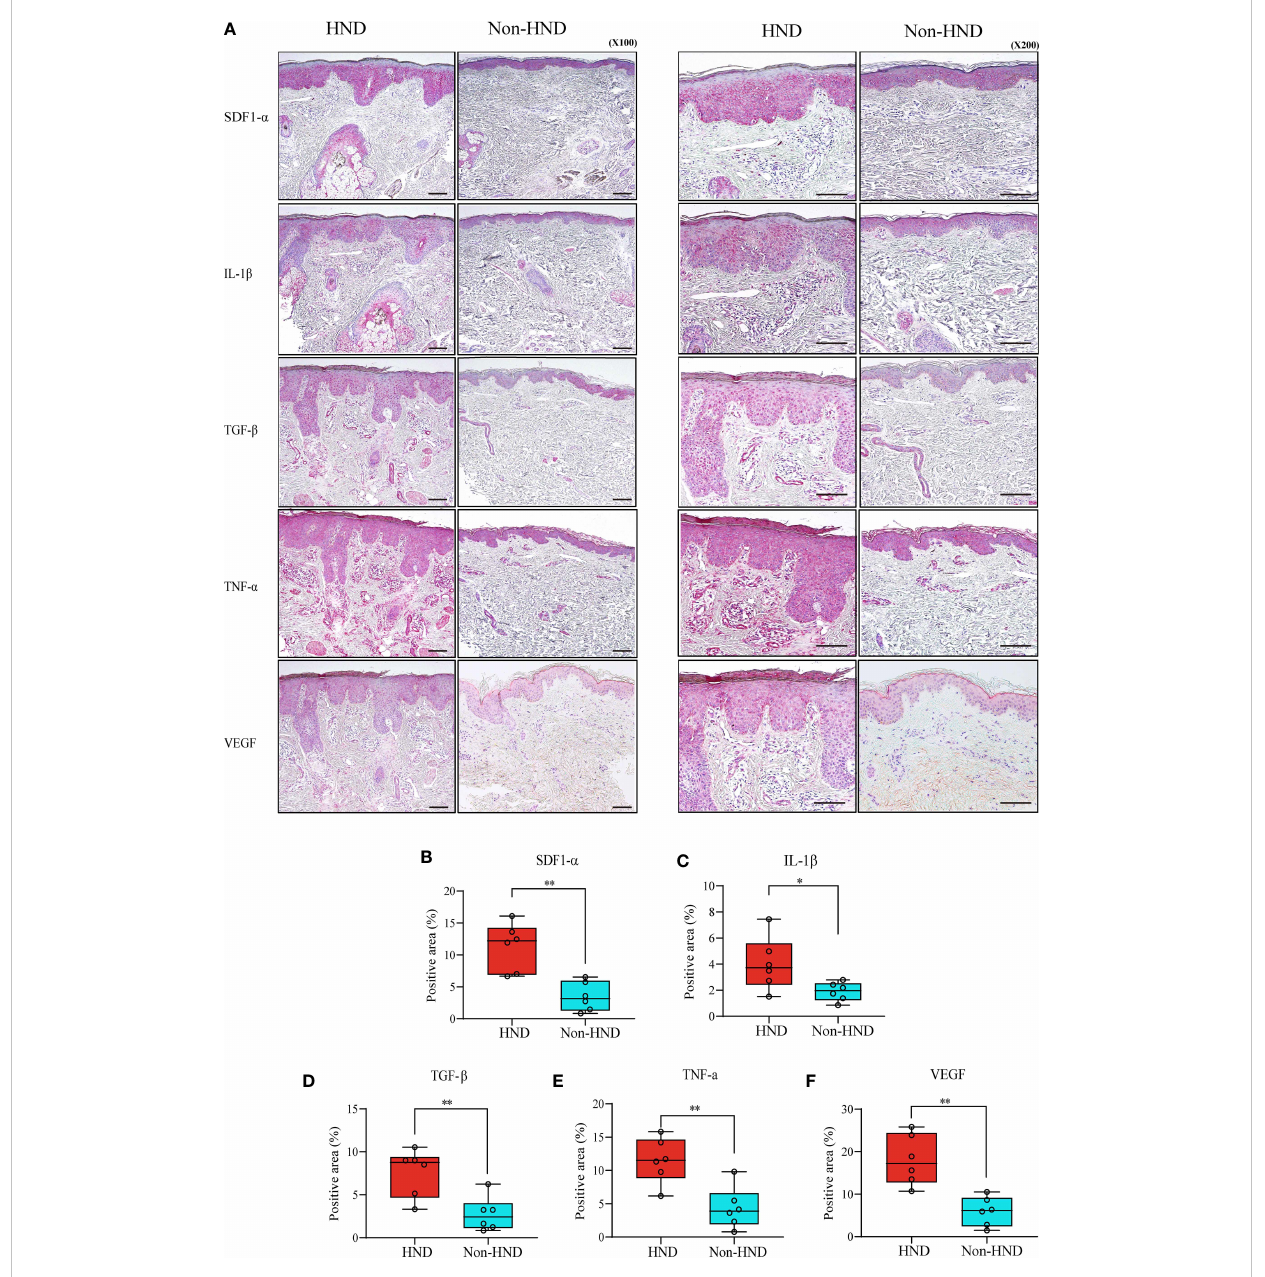
FIGURE 3 Immunohistochemistry of HND and non-HND facial skin specimens. (A) Representative histological image at 100x magni fi cation (left) and 200x magni fi cation (right). Quanti fi ed staining intensity of (B) SDF-1 a , (C) IL-1 b , (D) TGF- b , (E) TNF- a , and (F) VEGF. (Unpaired two-tailed t-test, SDF-1 a ; p = 0.0014, IL-1 b ; p = 0.0374, TGF- b ; p = 0.0058, TNF- a ; p = 0.0035, VEGF; p = 0.0002) HND, head and neck dermatitis; SDF-1 a , stromal cell-derived factor-1-alpha; IL-1 b , Interleukin-1-beta; TGF- b , transforming growth factor-beta; TNF- a , tumor necrosis factor-alpha; VEGF, vascular endothelial growth factor. * : p<0.05; ** :